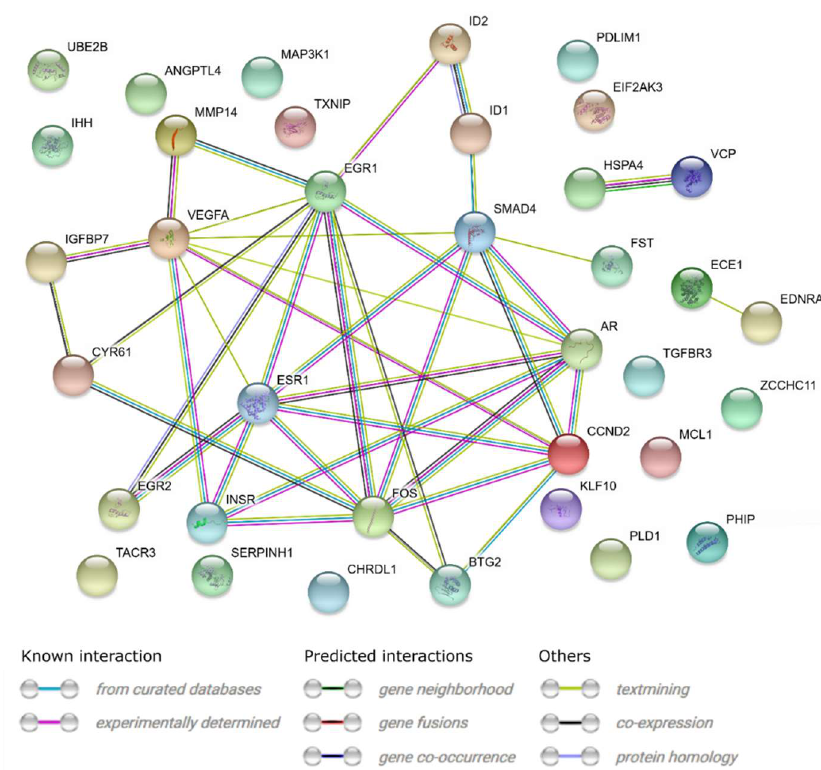
Int. J. Mol. Sci. 2018 , 19 , x Figure 5. STRING-generated interaction network between genes that belongs to the “response to hypoxia”, “response to organic substance”, “response to protein stimulus”, “transforming growth factor β receptor signaling pathway” and “transmembrane receptor protein serine threonine kinase signaling pathway” GO BP terms. The intensity of the edges reflects the strength of interaction score.